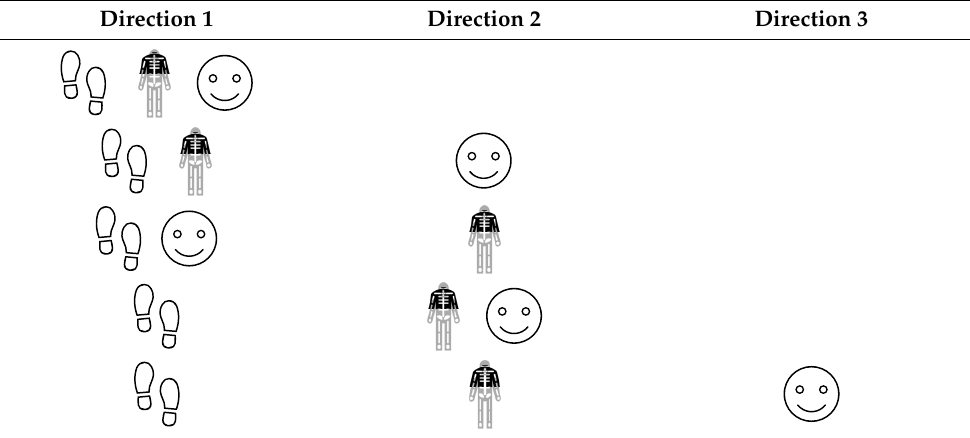
Table 1. Configurations of embodied engagement in Schegloff’s (1998) body torque classification.